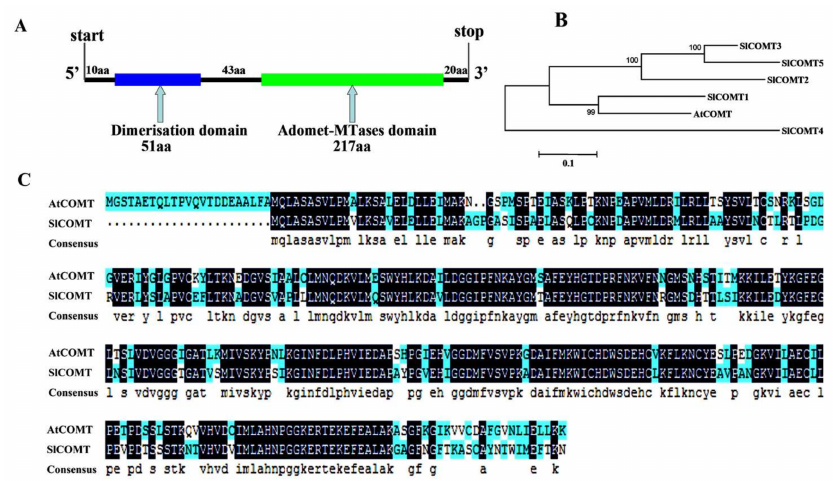
Figure 1. Bioinformatic analysis of the SlCOMT1 protein. ( A ) Two domains of the SlCOMT1 protein. ( B ) Phylogenetic tree was constructed using the five tomato COMT proteins and Arabidopsis AtCOMT protein. ( C ) Comparison of predicted SlCOMT1 protein sequence with AtCOMT. SlCOMT1 (XP_004235028.1), AtCOMT (NP_200227.1). Sl, Solanum lycopersicum ; At, Arabidopsis thaliana .